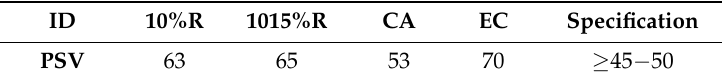
Table 7. Average Polished Stone Values for samples tested (10%R; 1015%R and CA) compared with PSVs of expanded clay and acceptance threshold values from Italian specifications (PSVs x